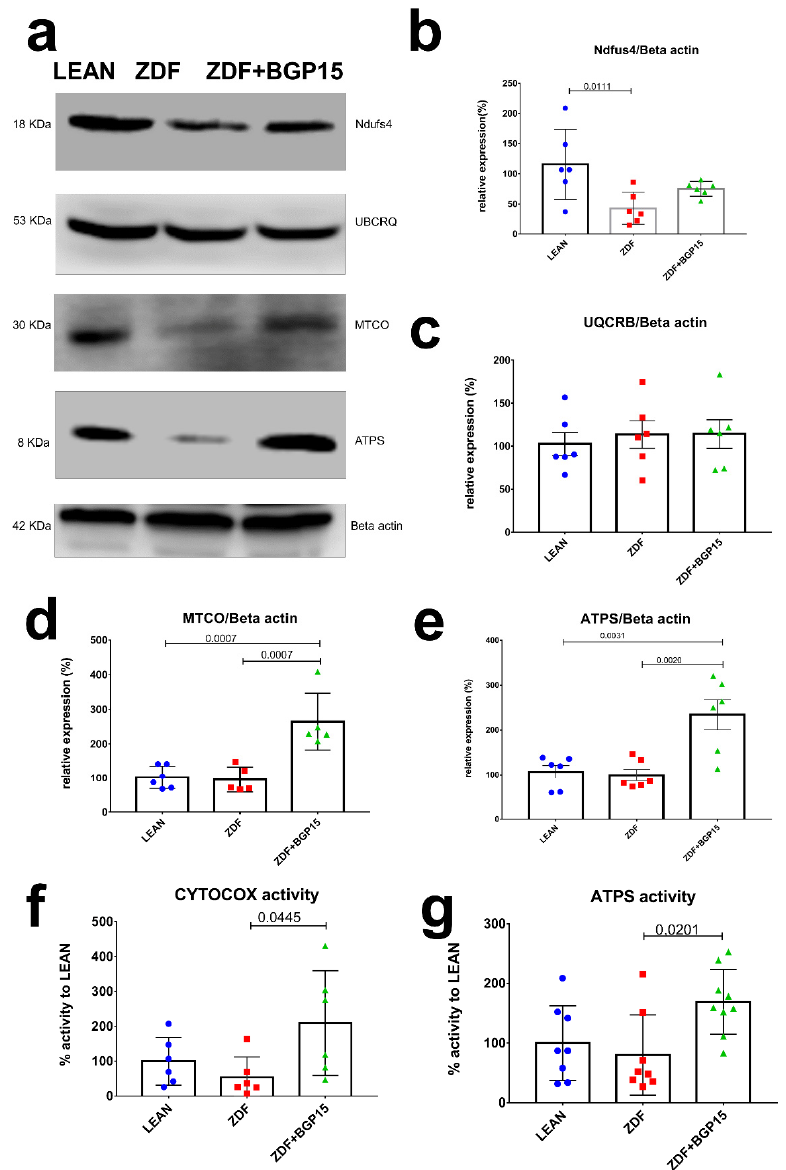
Figure 3. Protein expression and activity of electron transport chain complexes. BGP-15 treatment protects mitochondrial function against diabetes-induced oxidative stress in ageing ZDF rat myo- cardium. ( a ) A representative Western blot for electric transport chain complex I, III, IV, and V in ZDF rat myocardium treated with BGP-15. ( b – e ) Quantitative band density analyses of the ETC proteins normalized to Beta actin and expressed in the percentage of LEAN (that was considered 100%). ( f , g ) Graphs show MTCO (aka CYTOCOX) and ATP synthase enzymes activity analysed by microplate assays. Results are expressed as percentage of LEAN (which was considered 100%). All data are presented as the average outcome in a group (mean) ± standard deviation (SD). Statistical analysis was carried out by GraphPad Prism 7.00: D’Agostino and Pearson normality test was used